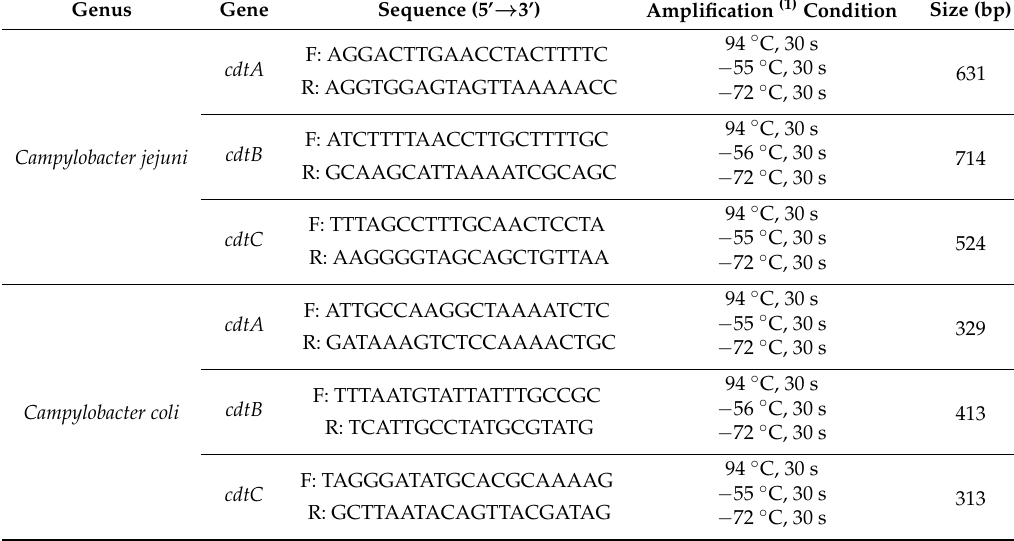
PCR primers and amplification conditions used to analysis of cdt genes for Campylobacter